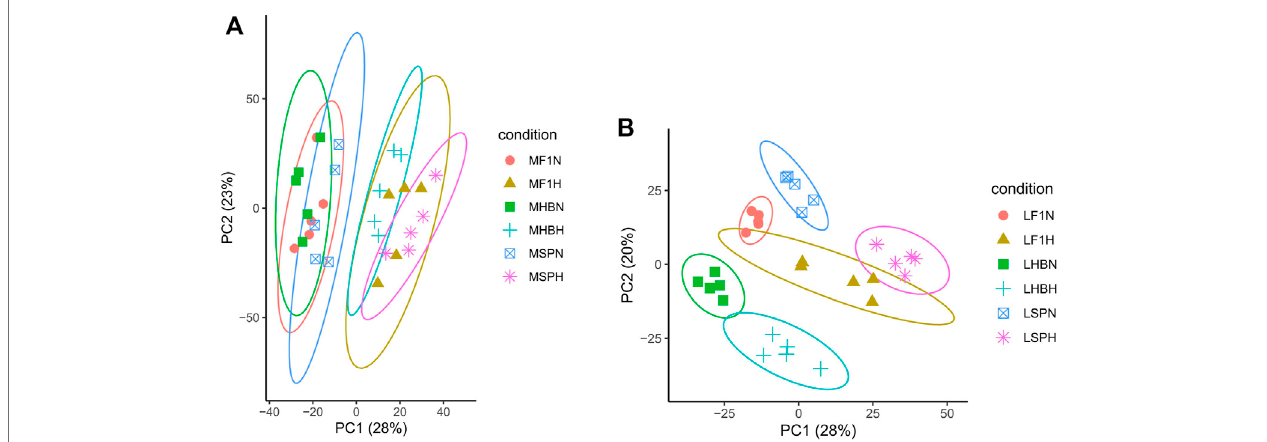
FIGURE 1 | Principal component analysis of gene expression in the muscle (A) and liver (B) samples (M, Muscle; L, Liver; HB, Hebao red carp; SP, Songpu mirror carp; F1, Hybrid F1 carp; H, Hypoxia-stressed samples; N, Normal oxygen samples; the samples used were MHBN1, MHBN2, MHBN3, MHBN4, MHBN5, MHBH1, MHBH2, MHBH3, MHBH4, MHBH5; MSPN1, MSPN2, MSPN3, MSPN4, MSPN5, MSPH1, MSPH2, MSPH4, MSPH5, MSPH6; MF1N1, MF1N2, MF1N3, MF1N4, MF1N5,MF1H1,MF1H2,MF1H3,MF1H4,MF1H5;LHBN1,LHBN2,LHBN3,LHBN5,LHBN6,LHBH1,LHBH2,LHBH3,LHBH4,LHBH;LSPN1,LSPN3,LSPN4, LSPN5,LSPN6,LSPH1,LSPH2, LSPH3,LSPH5,LSPH6;LF1N1, LF1N2, LF1N3, LF1N4, LF1N5, LF1H1, LF1H3, LF1H4, LF1H5, LF1H6). Differentcolorscorrespond to carp strains and different shades to different